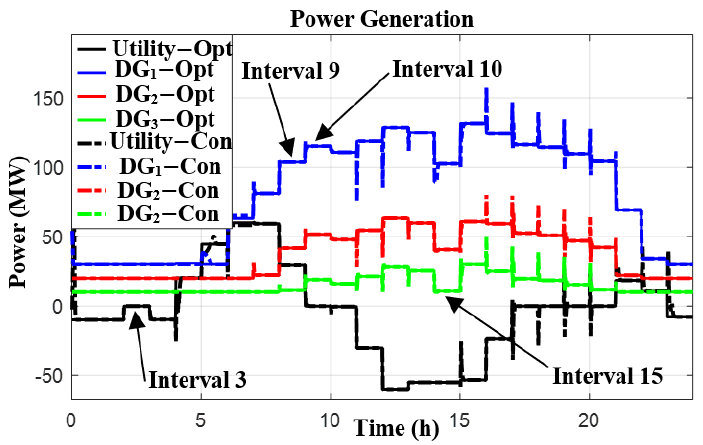
Figure 10. Power generation from consensus and EDP under a light load demand.